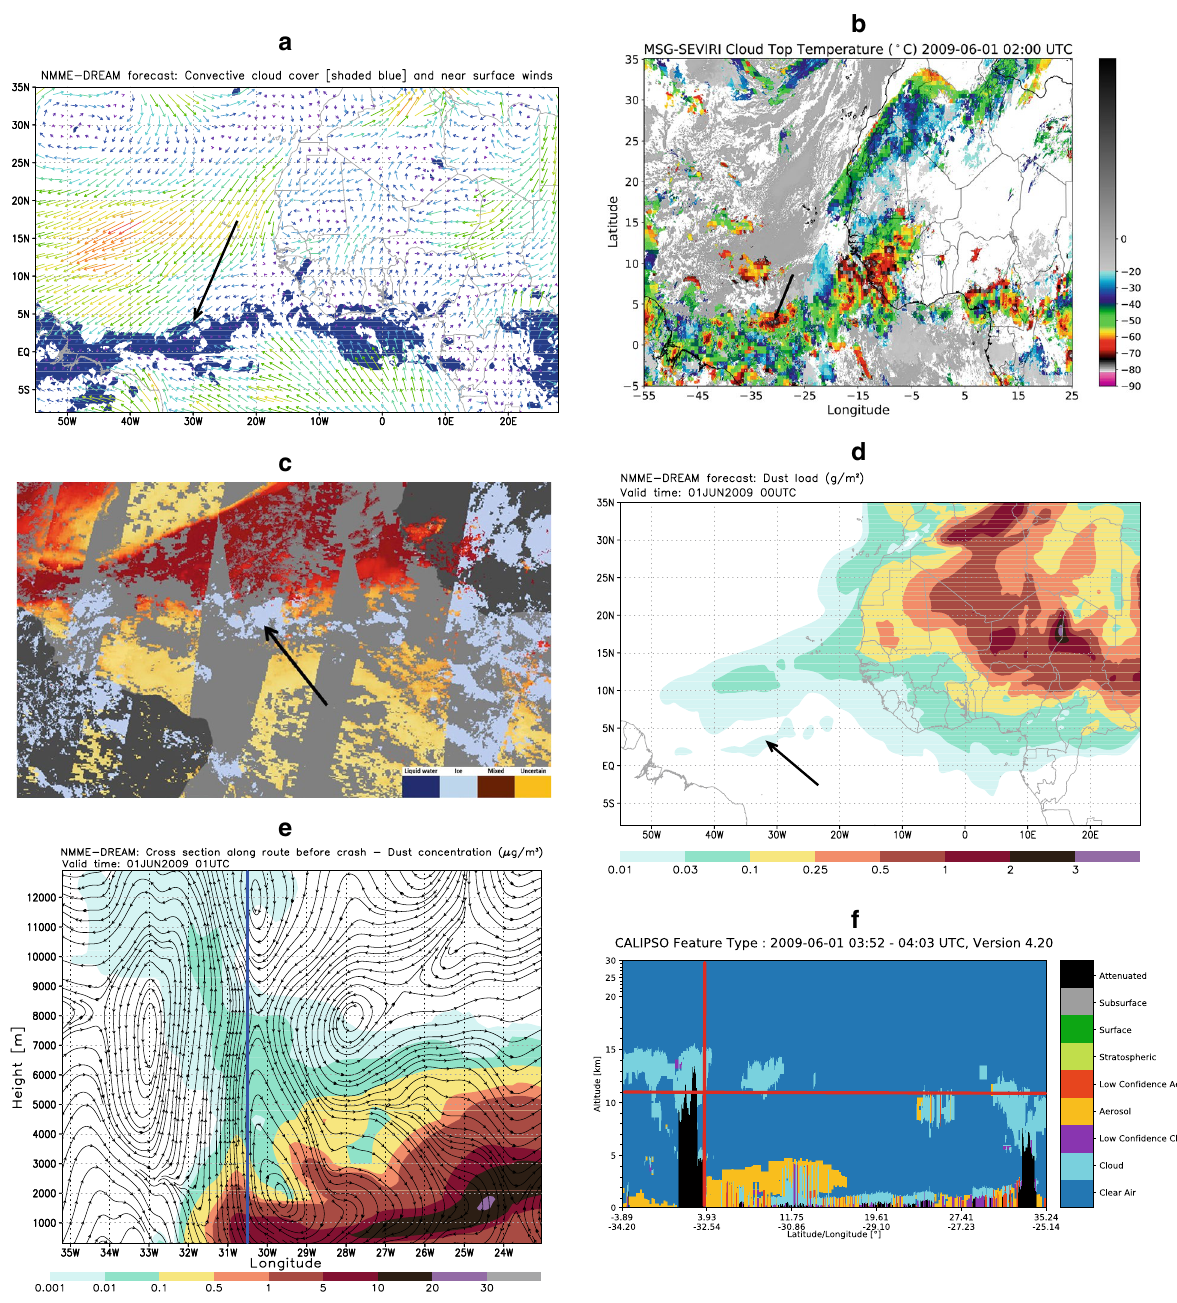
Figure 1. Atmospheric and dust conditions relevant for the AF477 accident. In the above images, arrows and thick lines indicate location of the accident. ( A ) Model convective cloud cover (shaded) and the near-surface wind (colored arrows) at 01 UTC 1 June 2009 indicating the location of the ITCZ characterized with strong wind convergence in the lower atmosphere and by the associated convection. ( B ) Cloud top temperatures observed by EUMETSAT MSG SEVIRI at 01 UTC 1 June 2009 showing the cluster of cumulonimbus clouds at the accident location. ( C ) Dust optical depth (NASA/SUOMI satellite) and ice cloud phase (NASA/MODIS satellite) observed on 31 May 2009 demonstrating the existence of a large-scale dust transport in Central Atlantic combined with the presence of cold clouds in the accident zone. ( D ) Vertically integrated dust − 2 concentration [ µ gm ] at 01 UTC 1 June 2009 as predicted by the model. ( E ) Dust concentration [ µ gm wind streamlines at 01 UTC 1 June 2009 in the vertical section crossing the atmosphere along the AF477 flight. Dust was lifted by strong upward convection motion from the lower levels to the upper troposphere. The vertical red tick line indicates the accident location ( F ) CALIPSO/CALIOP profile at 02:14 UTC, 1 June 2009 shows cold clouds in the upper troposphere and dust in its lower